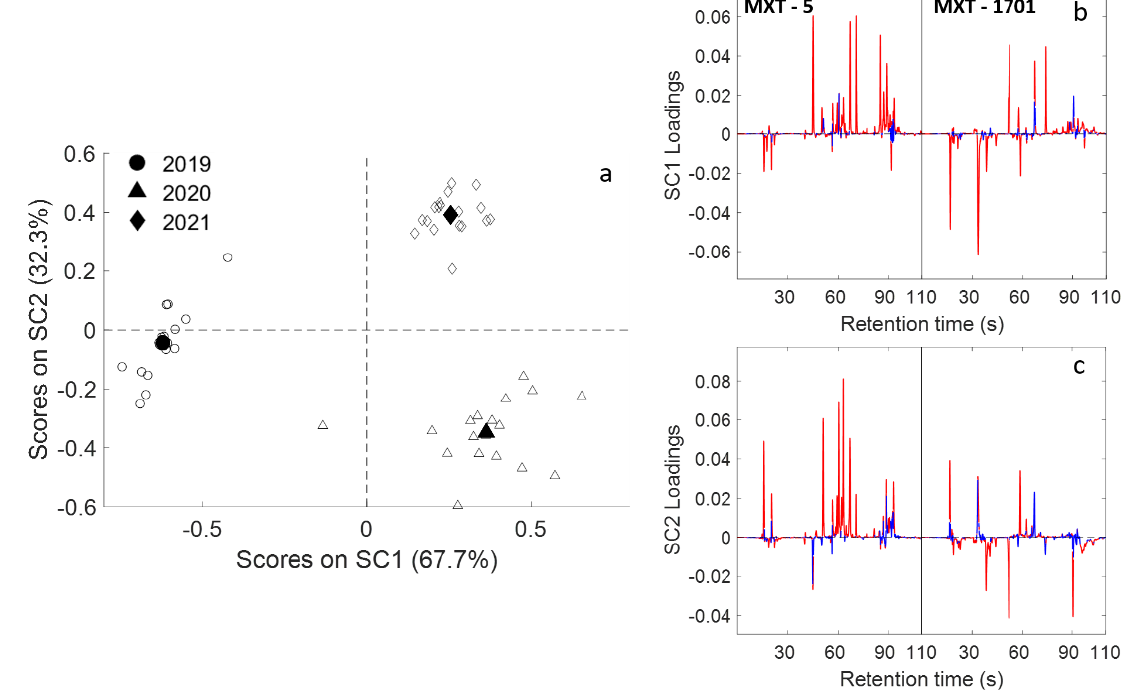
Figure 4. SCA for the effect of the factor “year”. ( a ) SC1 vs. SC2 score plot. Empty symbols represent the projected residuals; ( b ) SC1 and ( c ) SC2 loadings plot. In the loading plots, red lines indicate statistically significant regions, whereas blue lines indicate regions associated with loadings statistically indistinguishable from zero.